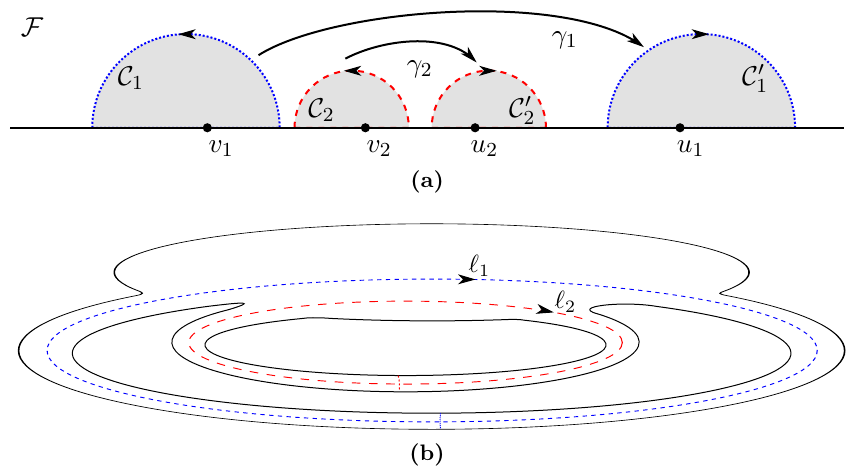
Figure 8. The Schottky group construction ((cid:12)gure 8a) of a planar g = 2 surface with b = 3 borders ((cid:12)gure 8b). The construction induces a loop basis f ‘ 1 ; ‘ 2 g on the